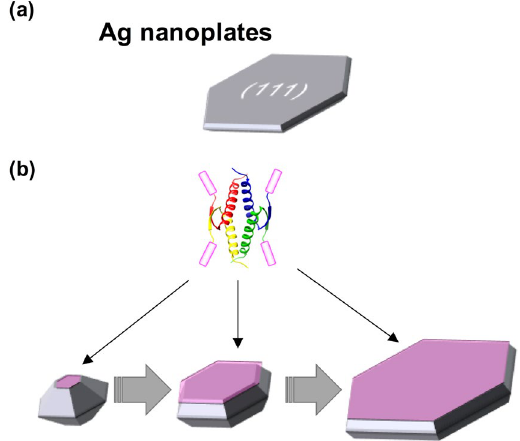
Figure 6. ( a ) Silver nanoplates are mainly enclosed by {111} surfaces. ( b ) A proposed nanostructure control process by using TBP-p53Tet. The TBP-p53Tet recognizes and binds to the silver {111} surfaces, and reduce the rate of crystal growth on the {111}